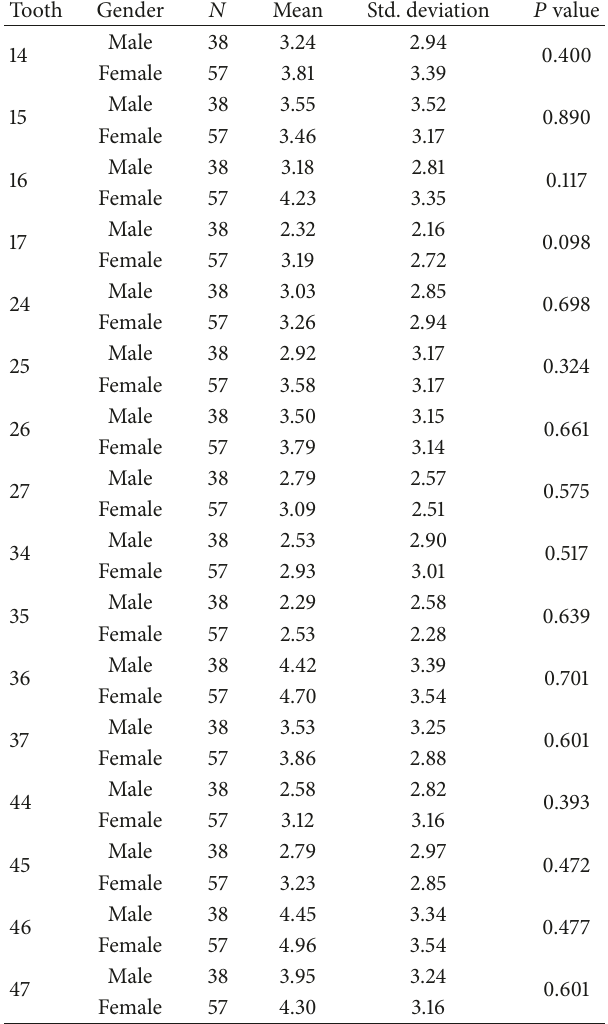
Table 3: Comparison of the mean occlusal wear scores of each tooth between males and females using independent 𝑡